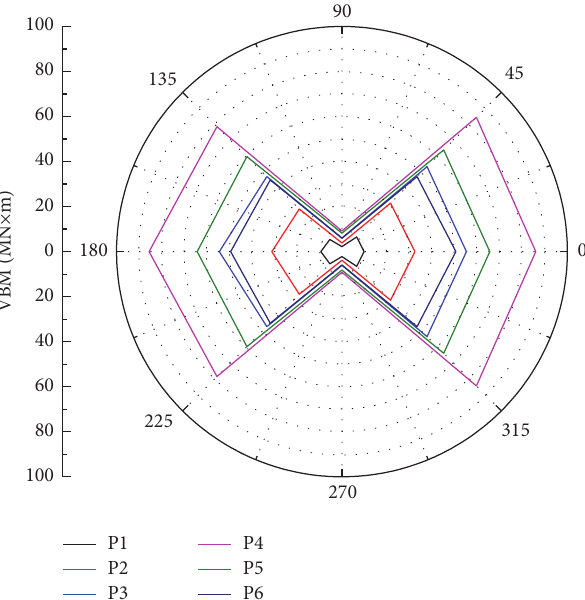
Figure 23: VBM of main hull in different